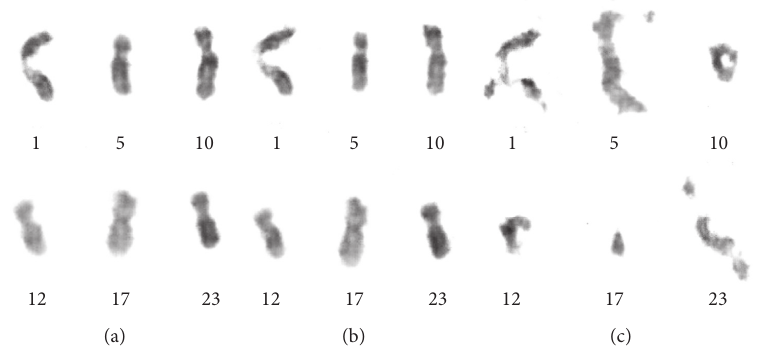
Figure 10: Comparisons among generated chromosome images achieved by MD-GAN with different number of generated chromosome images: (a) generated samples by setting n p as 50 and (b) and (c) samples of good and poor quality by defining n p as